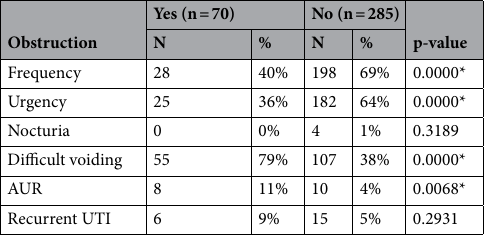
Table 1. Symptoms of women with or without BOO. *p-value < 0.05